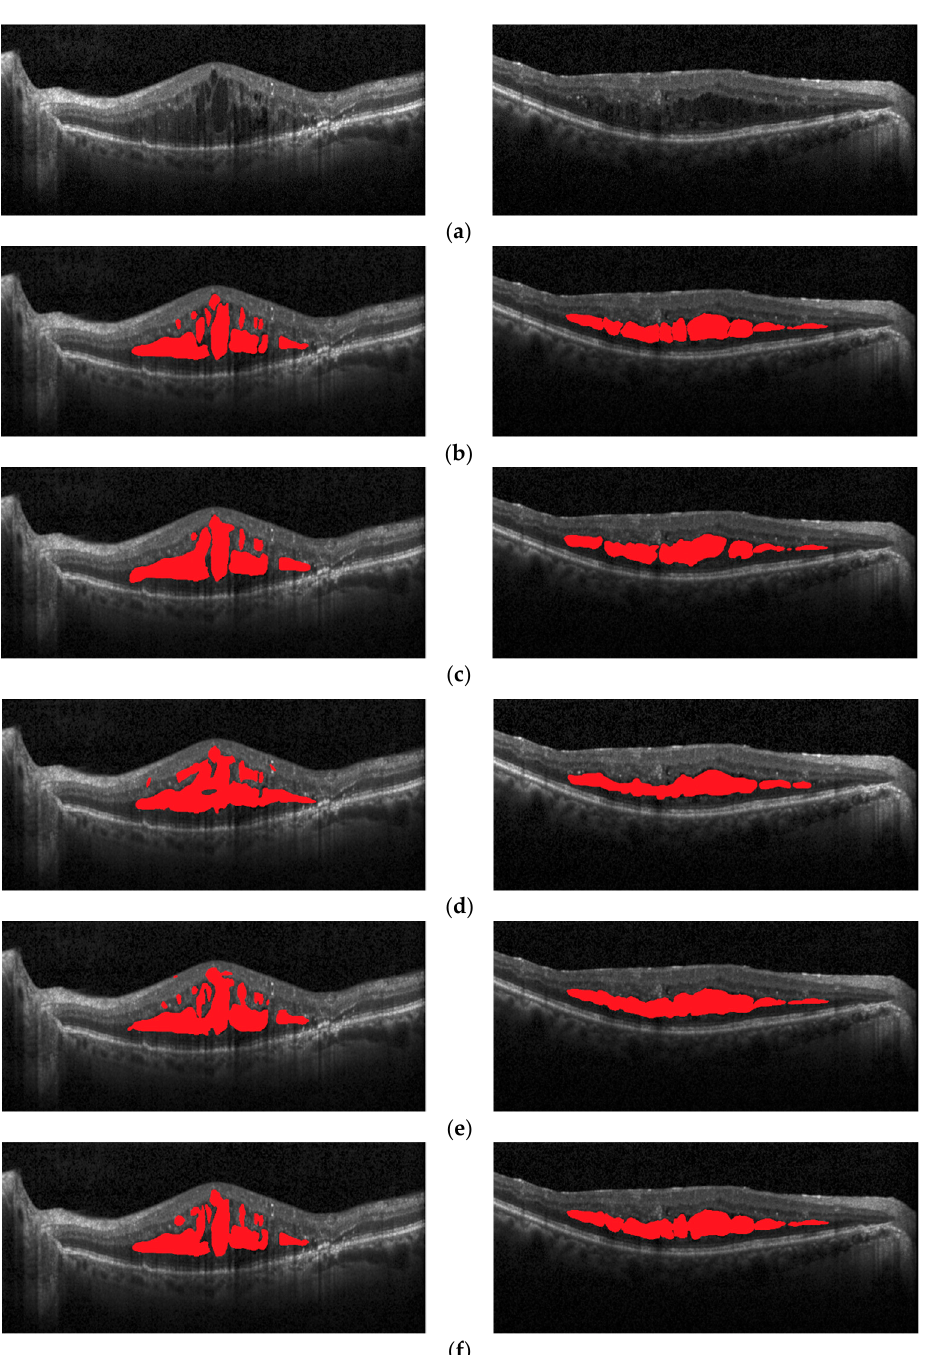
Figure 7. Segmentation effect of different models on the macular edema area: ( a ) original image; ( b ) expert 1 annotations; ( c ) expert 2 annotations; ( d ) TransUNet predictions; ( e ) Res-UNet++ predictions; ( f ) the proposed method predictions. Table 2. Comparison of test results of different methods in macular edema OCT images with multi- scale and multi-region.